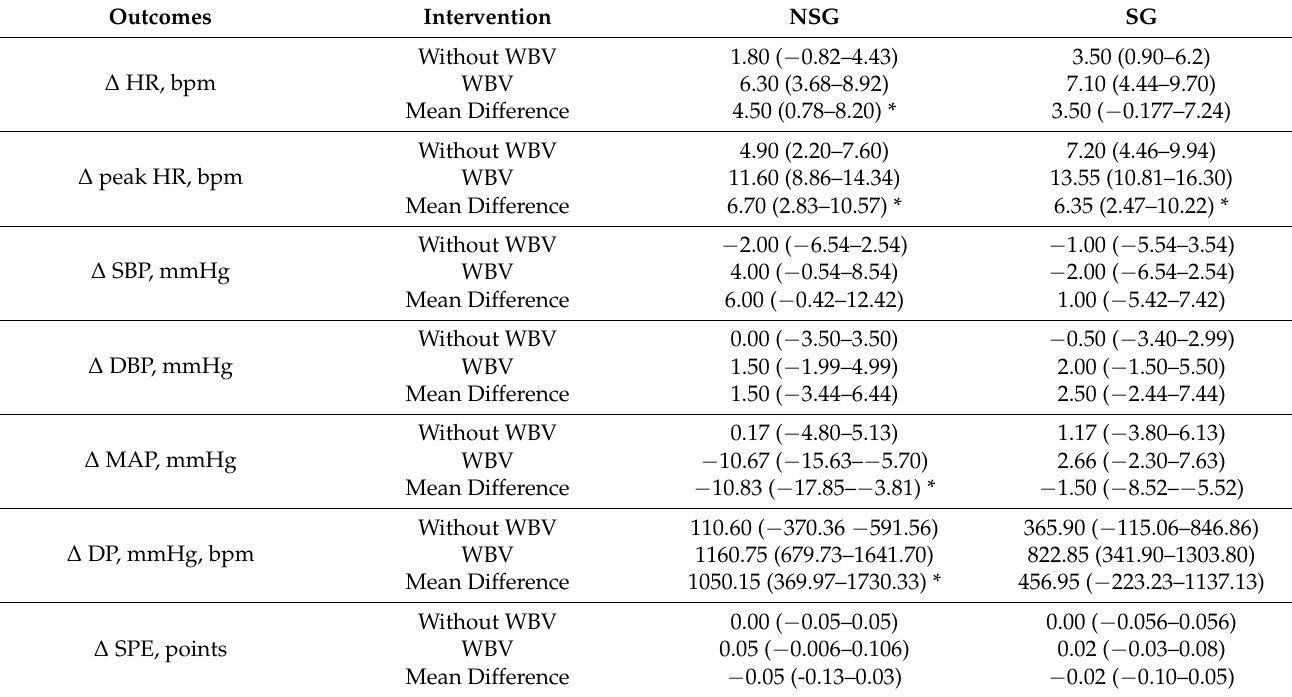
Table 2. Comparison of hemodynamic parameters between the interventions in the nonsarcopenic and the sarcopenic group. Outcomes